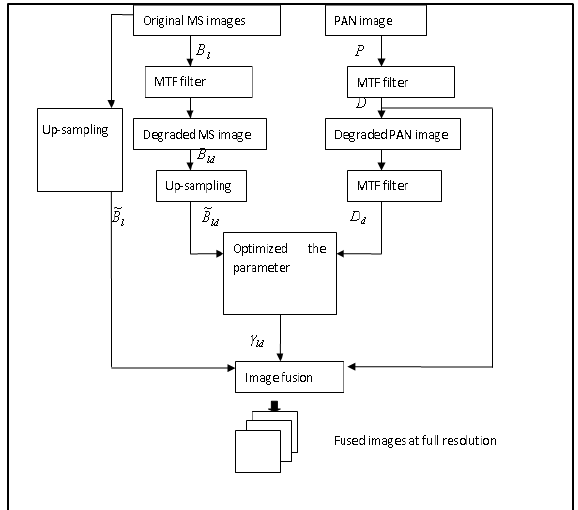
Figure 3. Flow chart of the improved high frequency modulating fusion method